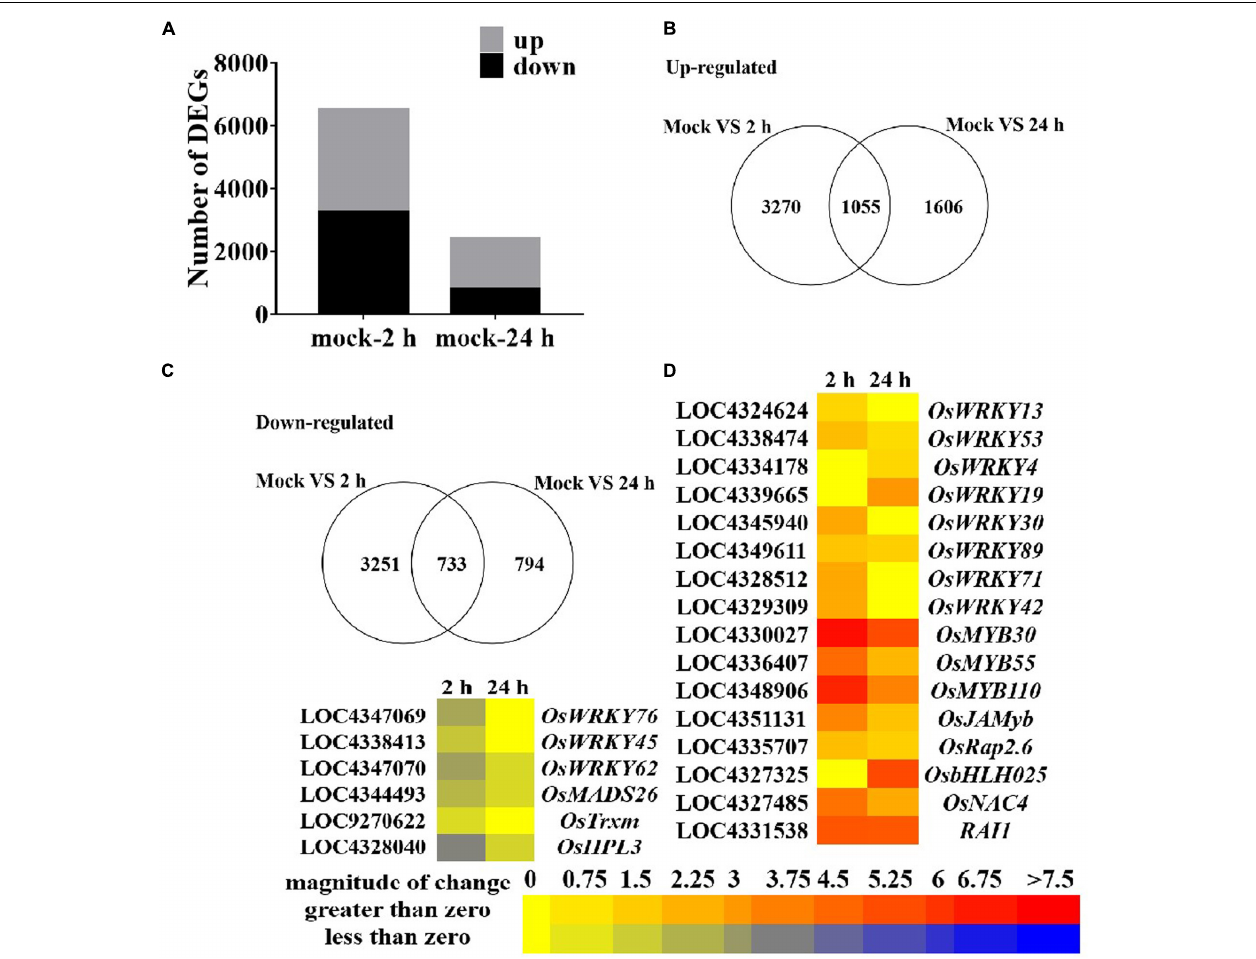
FIGURE 3 | An overview of guanine-regulated gene expression in rice leaves. (A) Number of up- and downregulated genes after guanine treatment at 2 and 24 hpt. (B) Venn diagram of upregulated genes in the mock vs. guanine-2 h and mock vs. guanine-24 h groups. (C) Downregulated expression of genes after 2 and 24 hpt of guanine treatment. (D) Heatmap analysis of disease resistance-related gene expression after guanine treatment at 2 and 24 hpt.